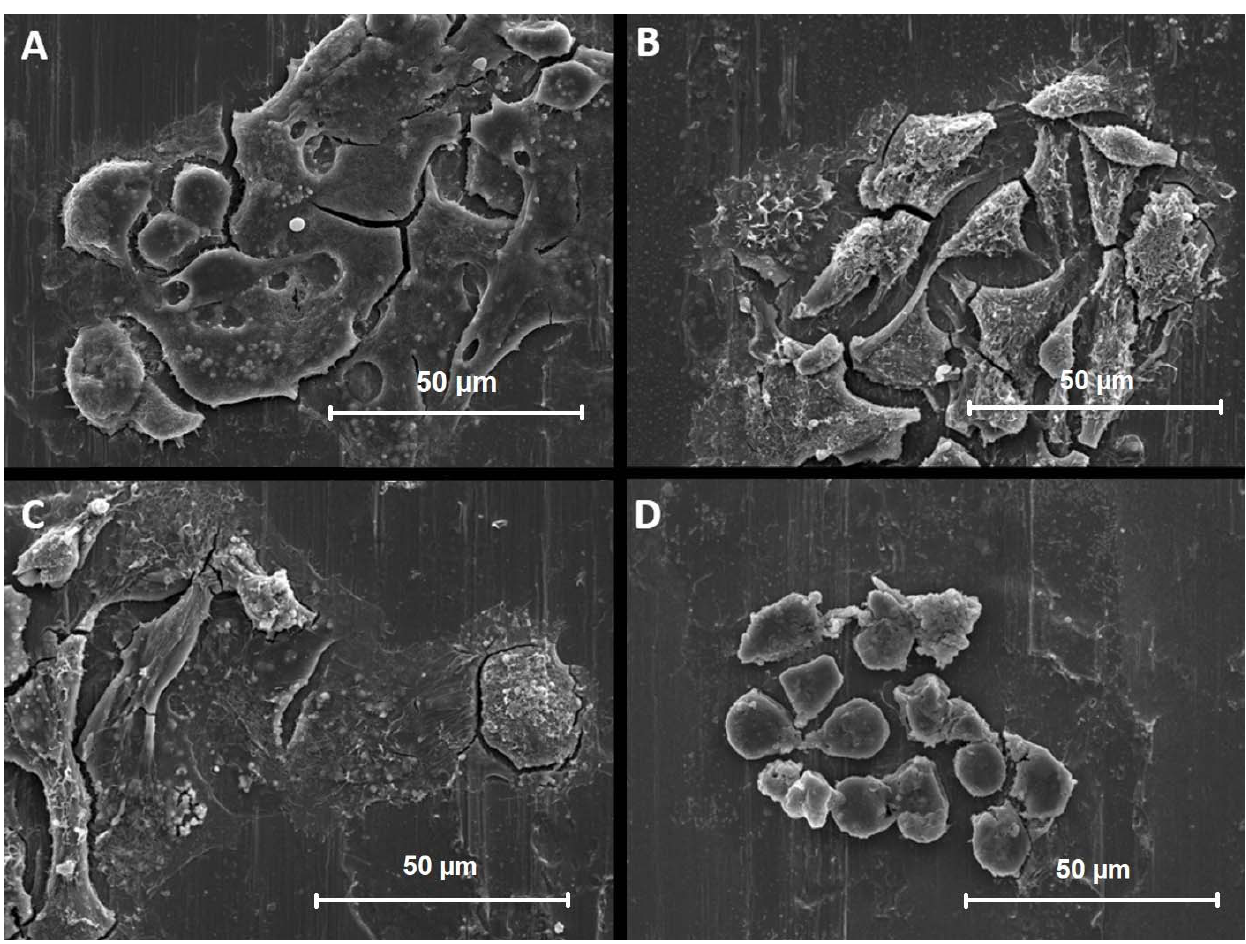
Figure 4. SEM photographs of the HepG2 cells exposed to increasing concentrations of AFB1 at 1000× magnification. HepG2 cells were exposed to different concentrations starting with the control ( A ), 5 μ M ( B ), 50 μ M ( C ), and 250 μ M ( D ).